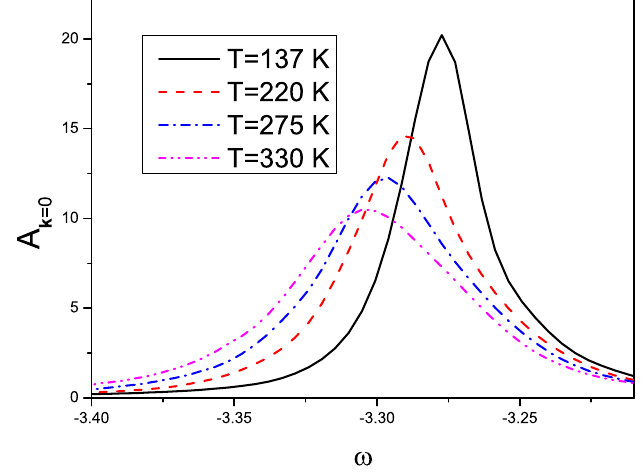
) for the rubrene model at momentum k = 0 a / ¯ h ) at λ = 0 . 12 and n = 0 . 002 for different a , with t = 0 . 18 t = 118 . 6 meV. c a a